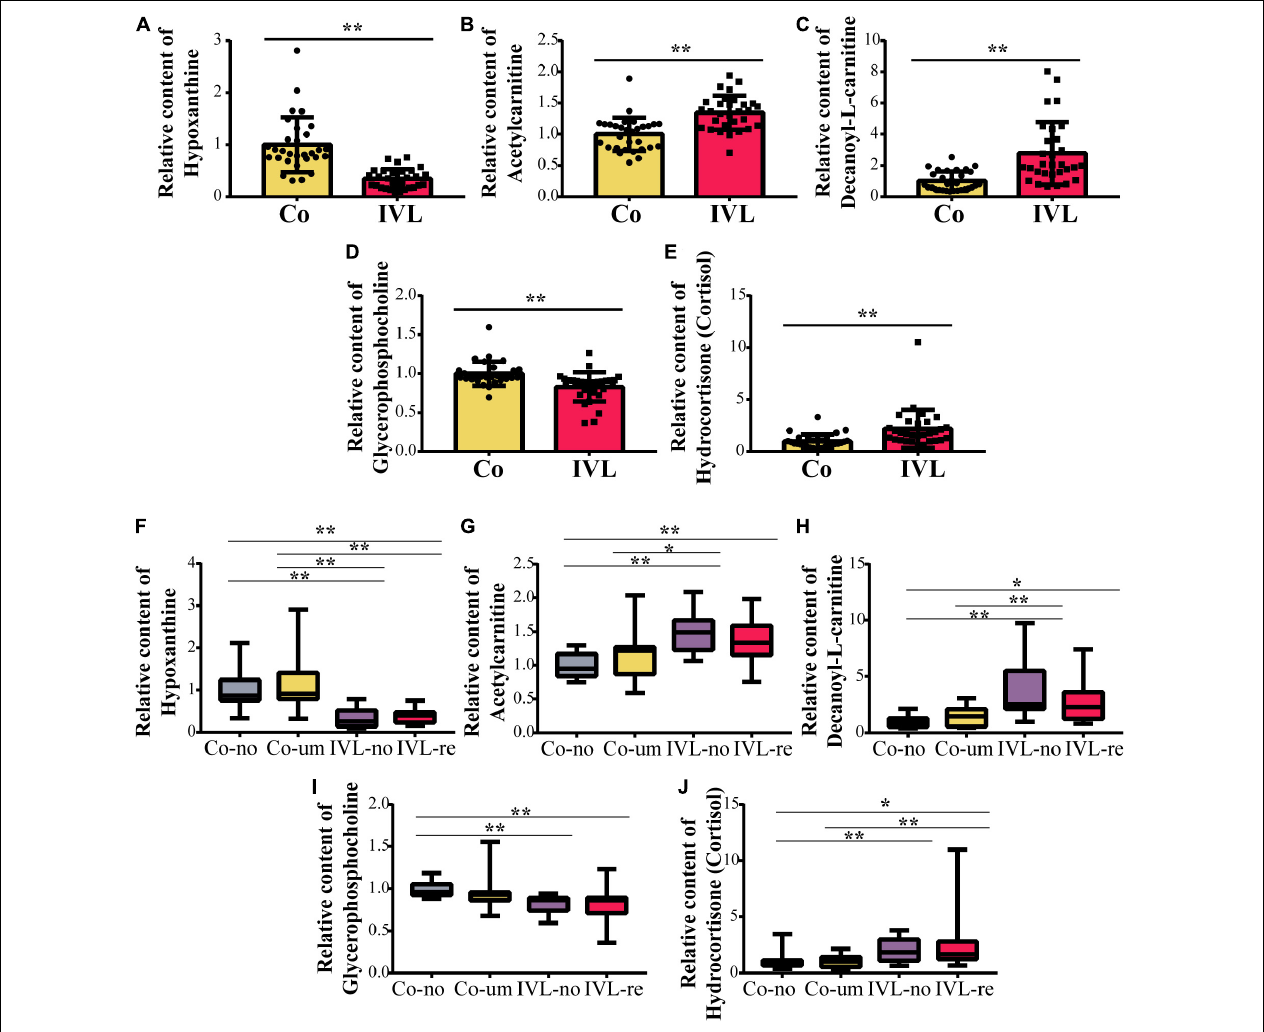
FIGURE 4 | The relative content of metabolites among groups. (A–E) Boxplots of the differentially expressed metabolites between the IVL and control groups (** P < 0.01), including hypoxanthine, glycerophosphocholine, hydrocortisone (cortisol), decanoyl-L-carnitine, and acetylcarnitine. (F–J) Comparisons of the expression of five metabolites as mentioned above among the Co-no, Co-um, IVL-no, and IVL-re groups (* P < 0.05, ** P < 0.01).